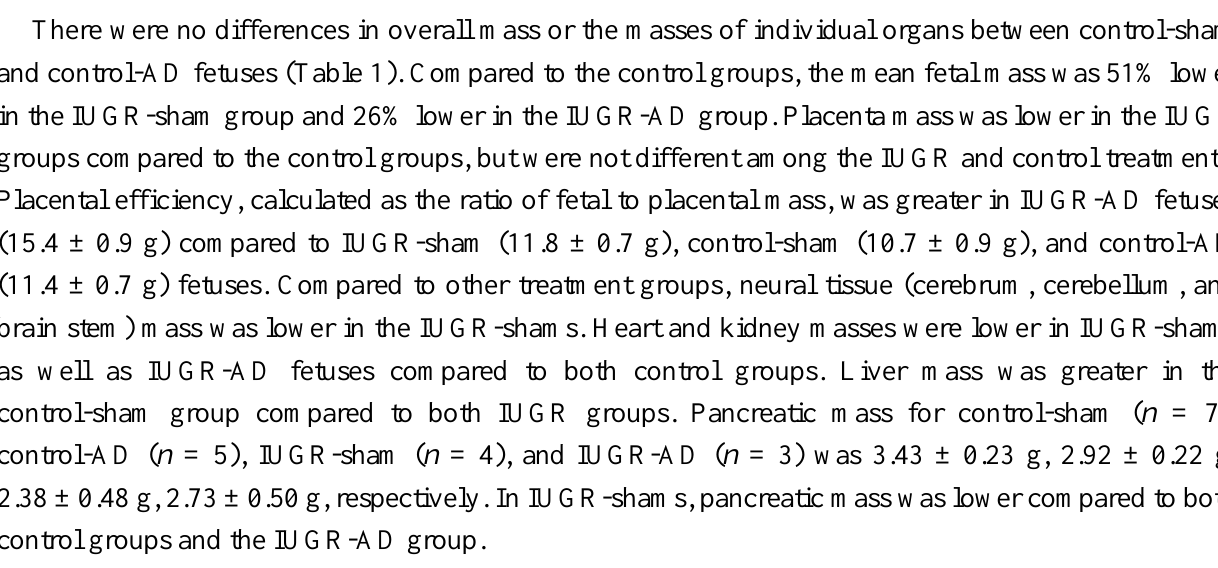
Table 1. Mean (±SEM) fetal, placental, and organ masses (g) for treatment groups. Treatment Group Control Sham ( n = 8) Control AD ( n = 7) IUGR Sham ( n = 7) IUGR AD ( n = 4) Fetus 3250 ± 149 a 3242 ± 177 a 1577 ± 250 b 2394 ± 414 c Placenta 319 ± 27 a 272 ± 8.7 a 137 ± 26 b Brain 50.5 ± 1.4 a